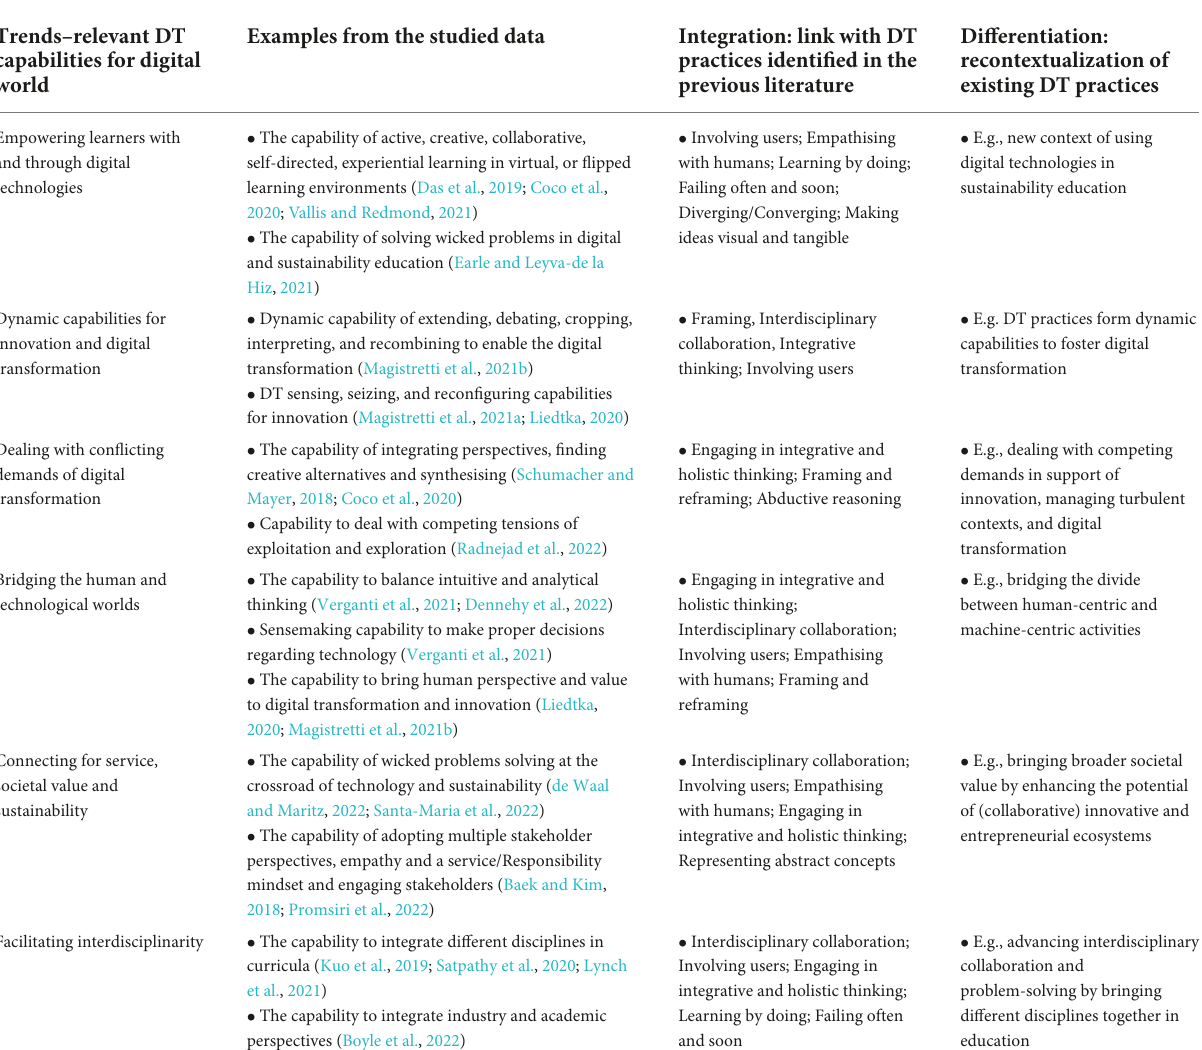
TABLE 4 Trends highlighting DT capabilities for the digital